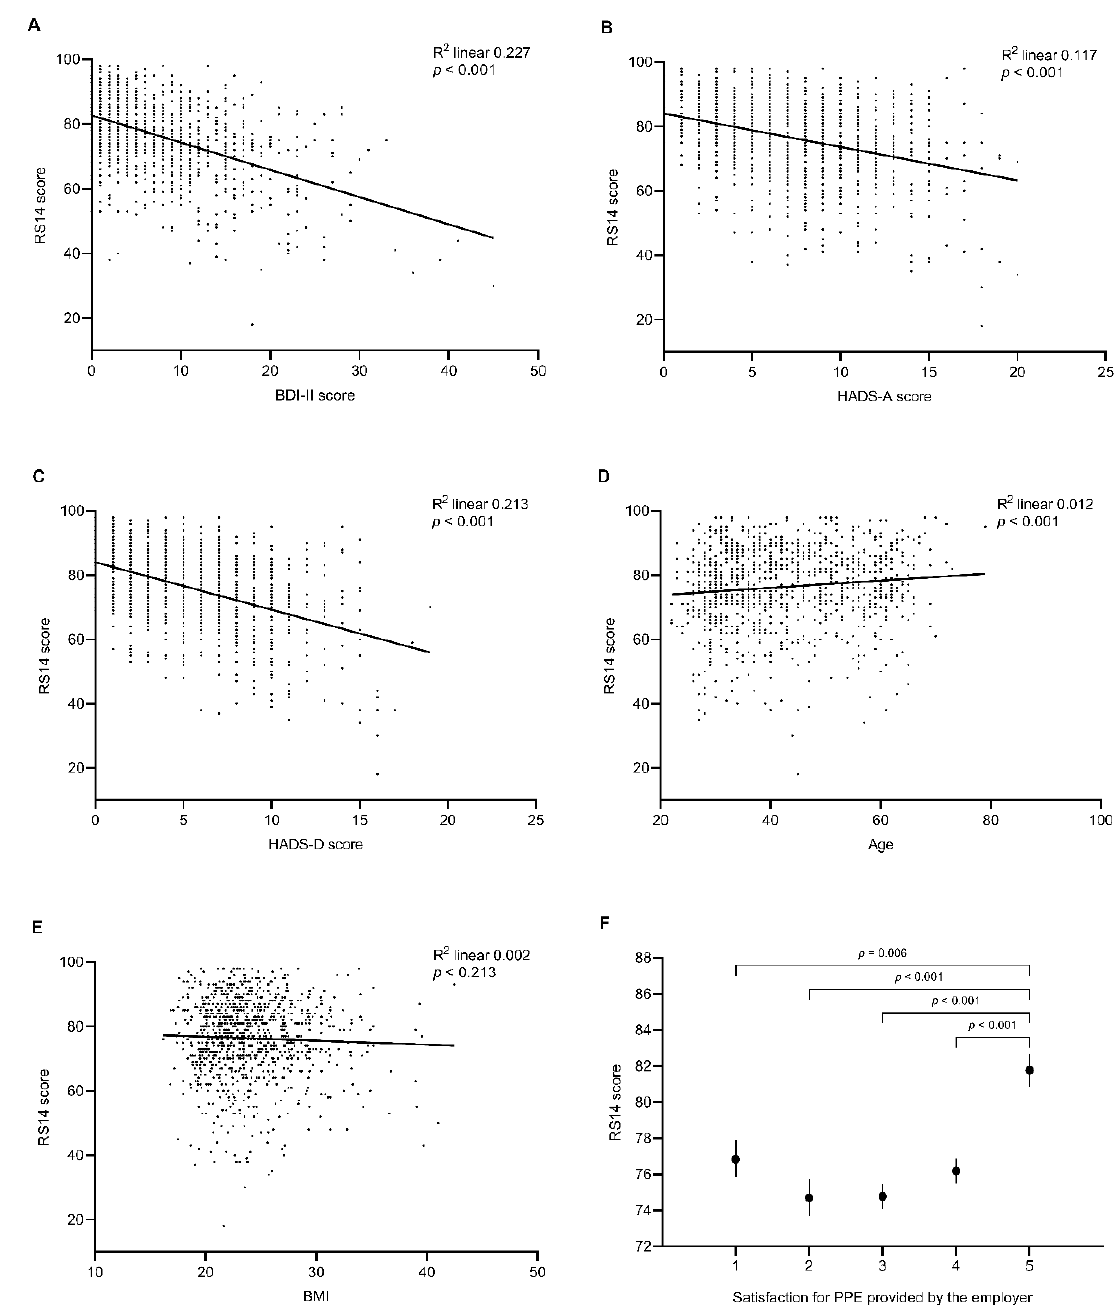
Figure 3. Linear regression (dot plot with overlayed regression line) showing the association between resilience and depression ( A , C ), anxiety ( B ), age ( D ), and BMI ( E ) in healthcare professionals. ( F ) shows levels of resilience in healthcare professionals after stratification for satisfaction for personal protective equipment. Data are expressed as mean and standard error of the mean. RS14: 14-item Resilience Scale; BDI-II: Beck Depression Inventory-II scale; HADS-A: Hospital Anxiety and Depression Scale-Anxiety; HADS-D: Hospital Anxiety and Depression Scale-Depression.